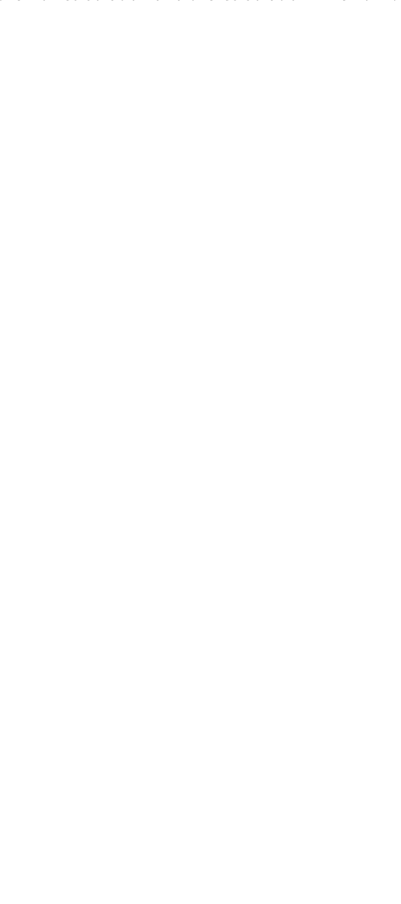
Figure 6 ( a ) The error between the CS solution and the analytical solution solution when t = 0.9; ( b ) the error between the ROECS solution and the analytical solution solution when t = 0.9; ( c ) the error between the ROECS solution and the CS solution when t =